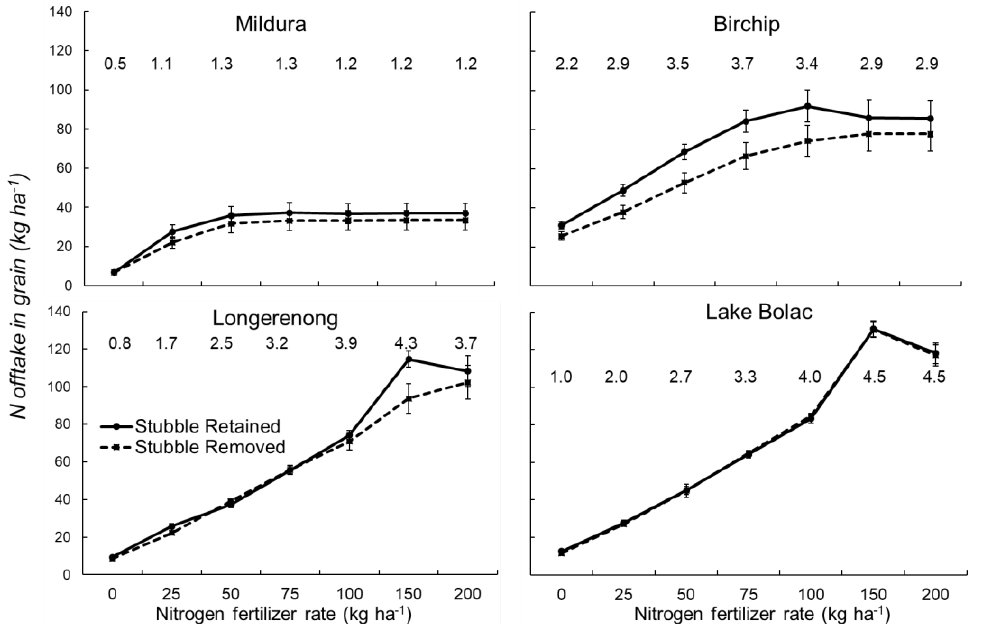
Figure 5. Effects of N application rate and stubble retention (retained vs. removed) on the mean (1990 – 2016) N offtake in grain at four field sites. Error bars represent ± standard error of the mean over the years of the simulation. Numbers at the top of the graphs are the average grain yield (t/ha) of the retained treatment.